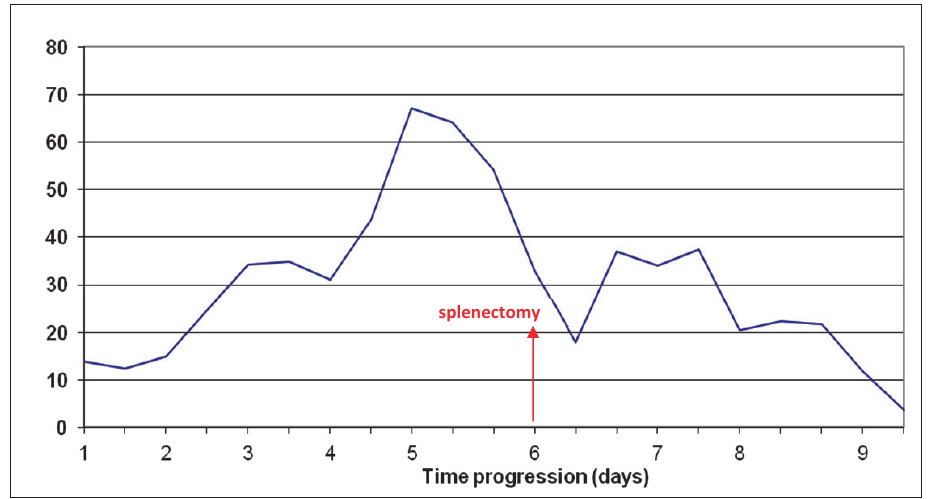
Fig. 2. WBC counts before and after splenectomy. Graph showing evolution of WBC counts (x10 9 /L) with a marked time point (day 6) at which splenectomy was